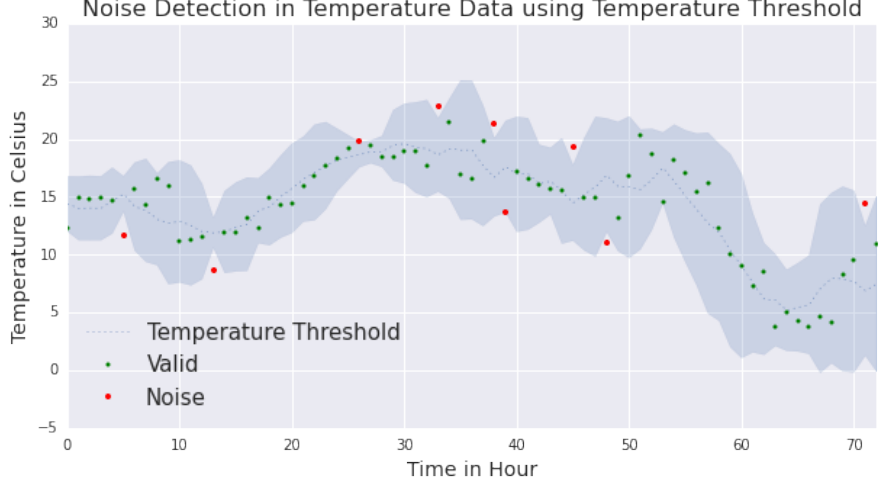
Figure 9. The figure indicates the detection of noise in the temperature data. Temperature Threshold (Equation (8)) is applied as a noise detection